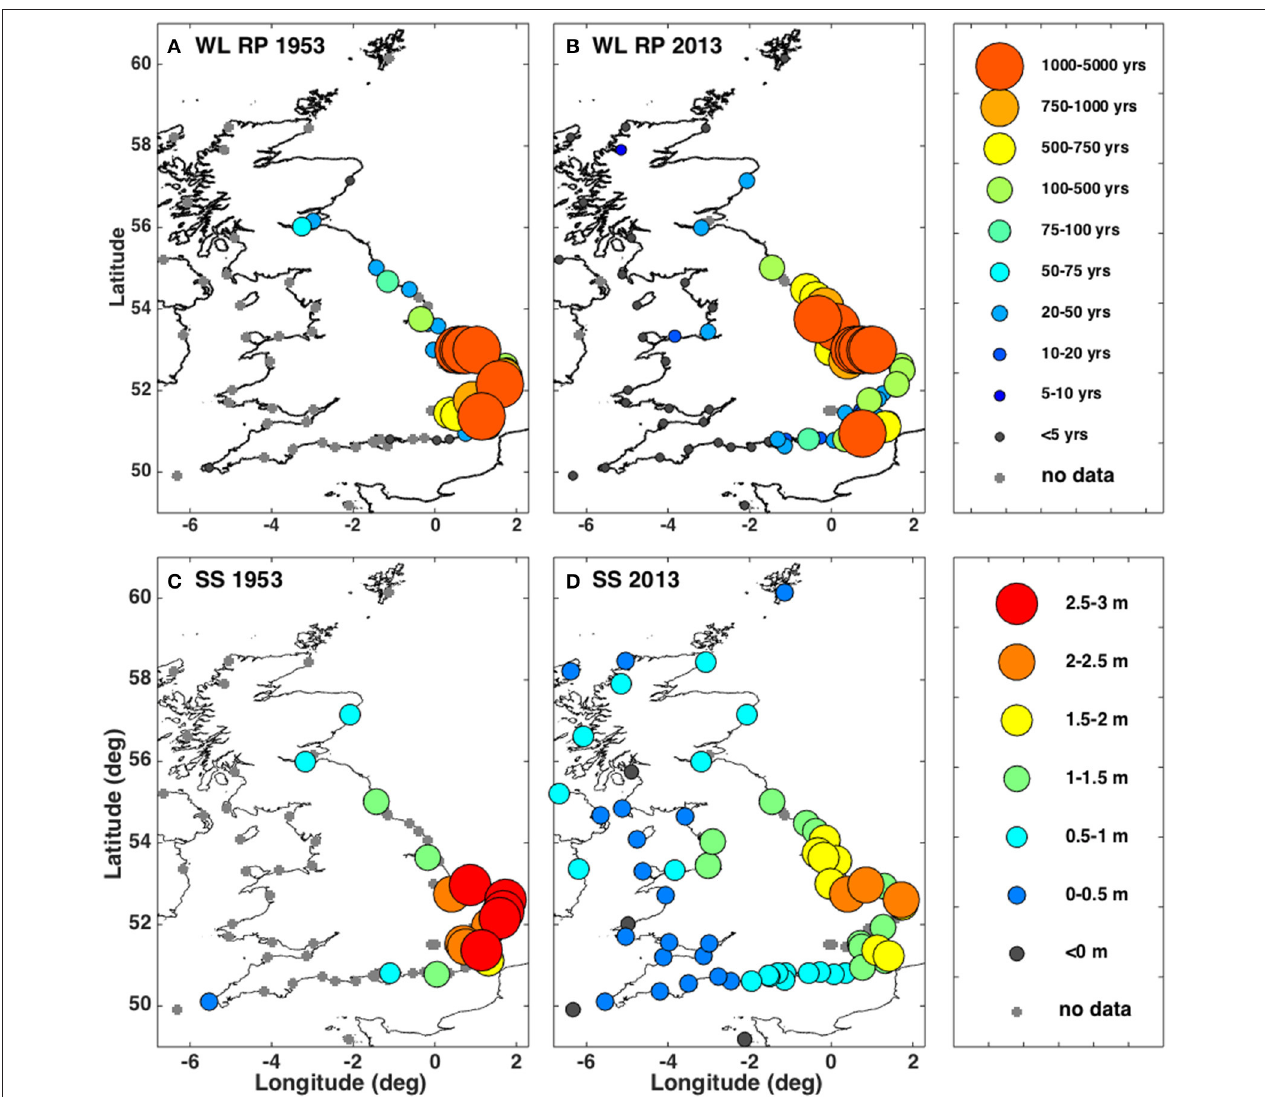
FIGURE 5 | Return periods of (A) 1953 and (B) 2013; and skew surge heights during (C) 1953 and (D) 2013 events. Note the return periods are offset for SLR in both events.